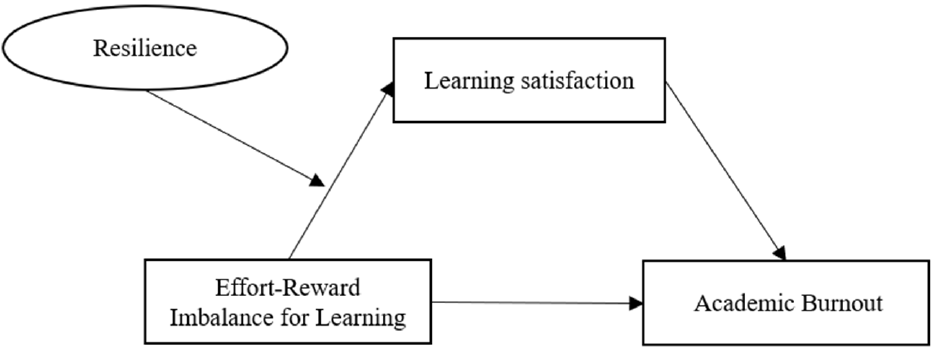
Figure 1. Proposed Figure 1. Proposed model.